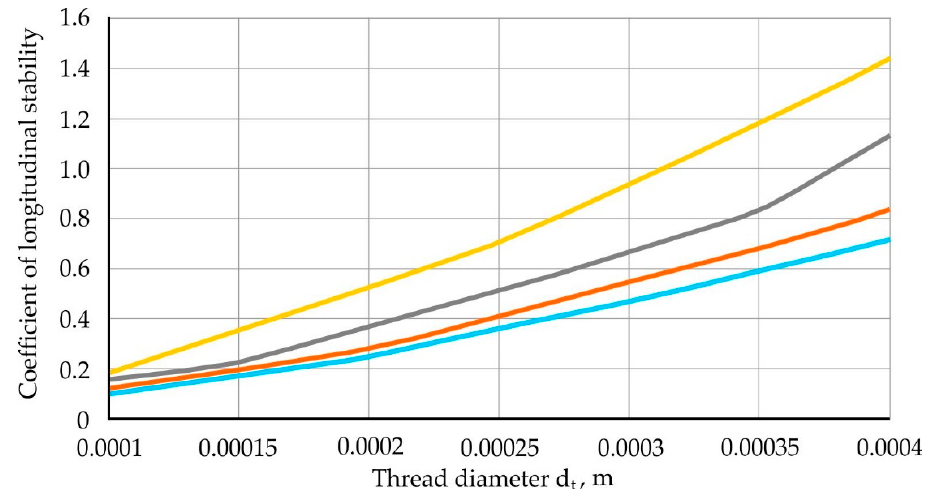
Figure 9. Dependence of the criterion of longitudinal stability of the thread ξ on the diameter of the thread d t at L = 0.01 m and P = 0.26·10 − 6 .